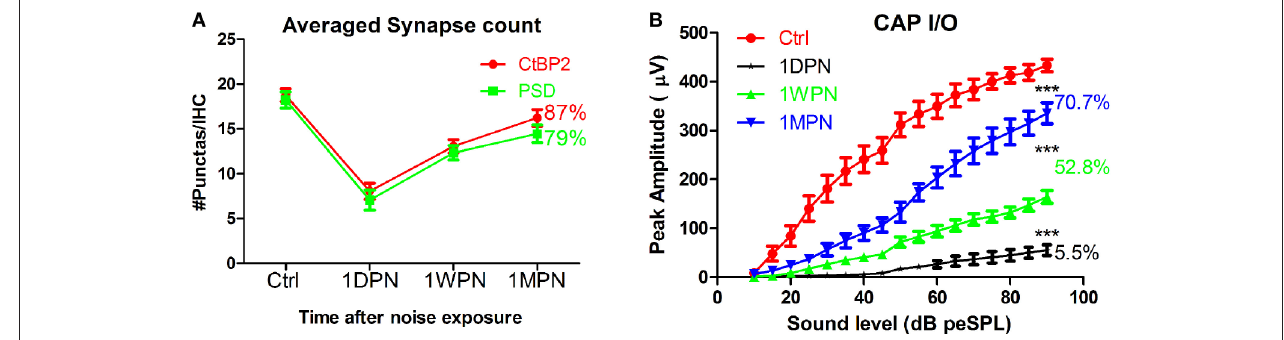
FIGURE 1 | Changes of synapse counts (A) and input/output functions of compound action potentials by click (B). Synapses were stained by antibodies for C-terminal binding protein 2 (CtBP2) and post-synaptic density 95. One-way ANOVA was performed for CAP amplitude at 90dB peSPL (peak equivalent sound pressure level). The number of percentages was calculated against the control ( *** p < 0.001 ).